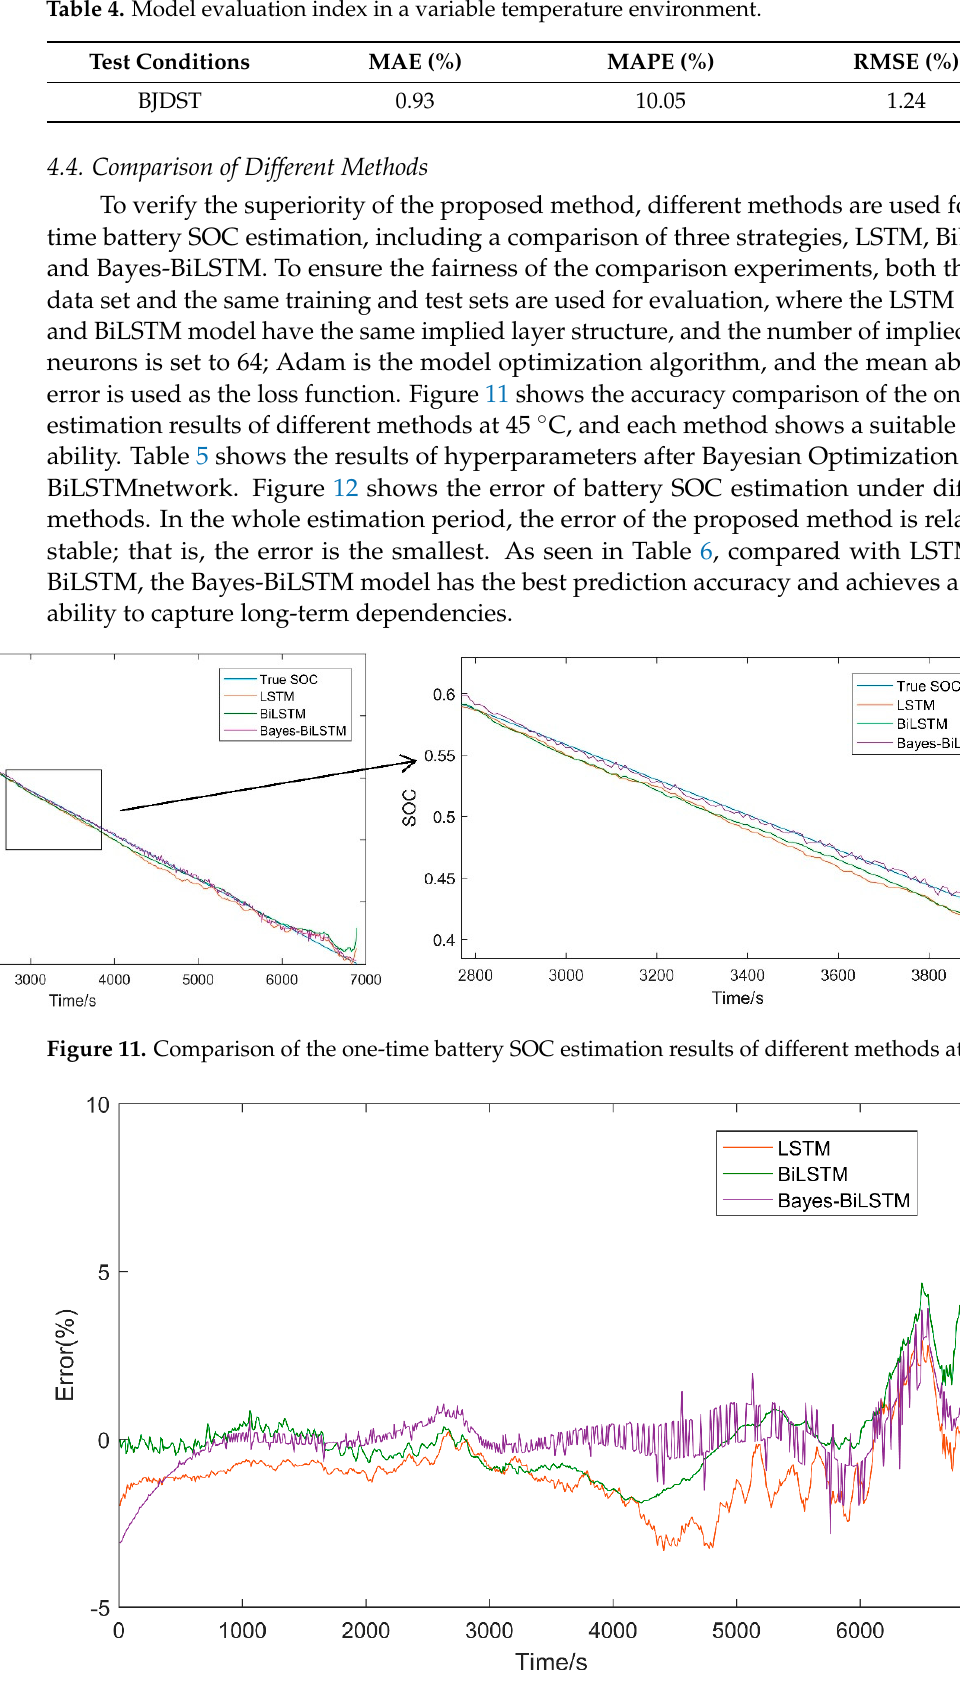
Figure 12. Estimation errors of different methods at 45 °C.